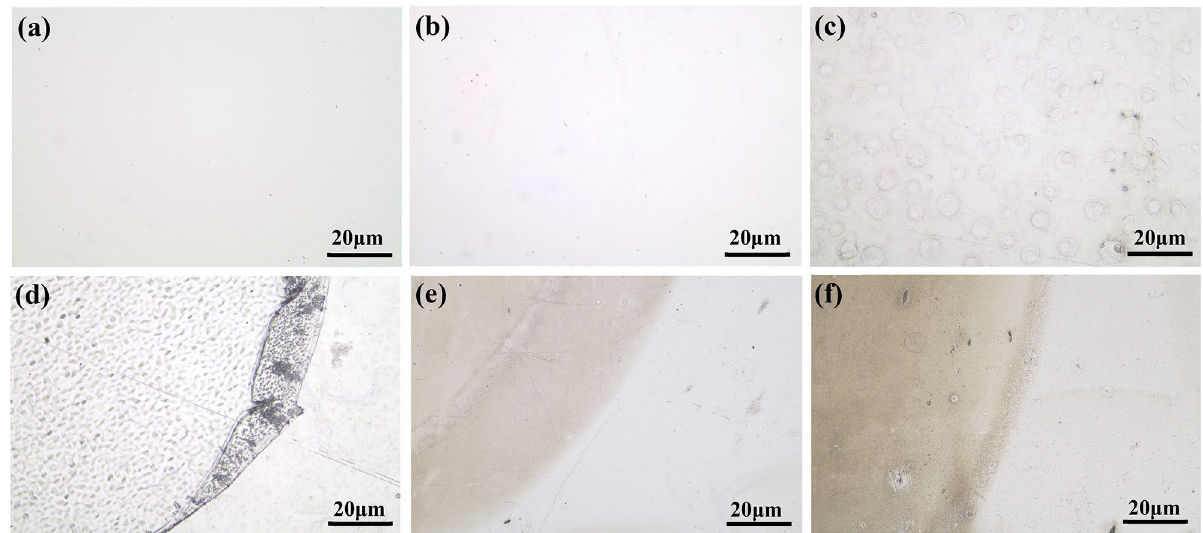
Figure 5. The KDP surface: ( a ) before soaking, ( b ) after soaking in BT1 for 14 h, ( c ) after soaking in BT2 for 14 h, ( d ) after soaking in BT3 for 14 h, ( e ) after soaking in BF + Ba(OH) for 14 h and ( f ) after soaking in BT1 + Ba(OH) for 14 h.